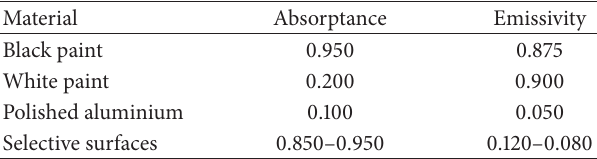
Table 4: Absorptance and emissivity of sample materials